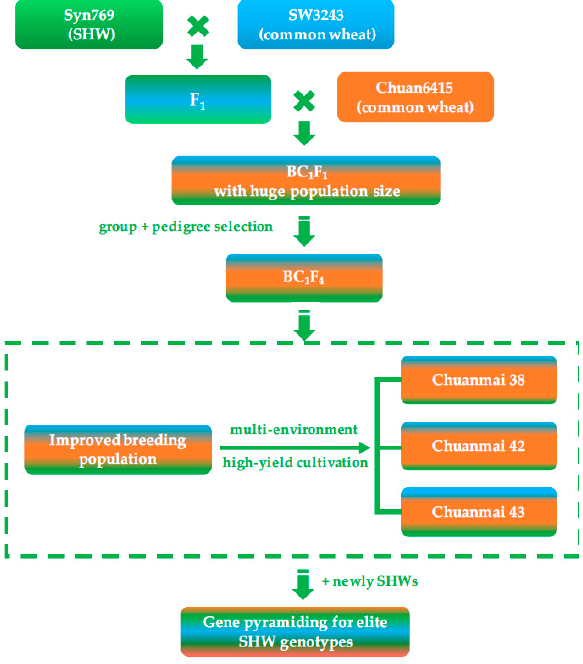
Figure 2. Direct application of SHW and breeding procedure of Chuanmai 42. Under this breeding strategy, our team used one SHW line introduced from the International Maize and Wheat Improvement Center (CIMMYT), Syn769, successively crossed with two local common wheat lines, SW3243 and Chuan 6415, and three cultivars were bred: Chuanmai 38, Chuanmai 42, and Chuanmai 43. Among them, Chuanmai 42 was released in 2003 and was the first commercial SHW derivative in the world. In the Sichuan regional trials of wheat cultivars in 2002 and 2003, the average grain yield of Chuanmai 42 increased by 70.2% and 28.3%, respectively, compared to the check cultivars Chuanmai 28 and Chuanmai 107 (Table 2). Overall, grain yield increased by 35%, which broke the yield record of commercial cultivars in southwestern China